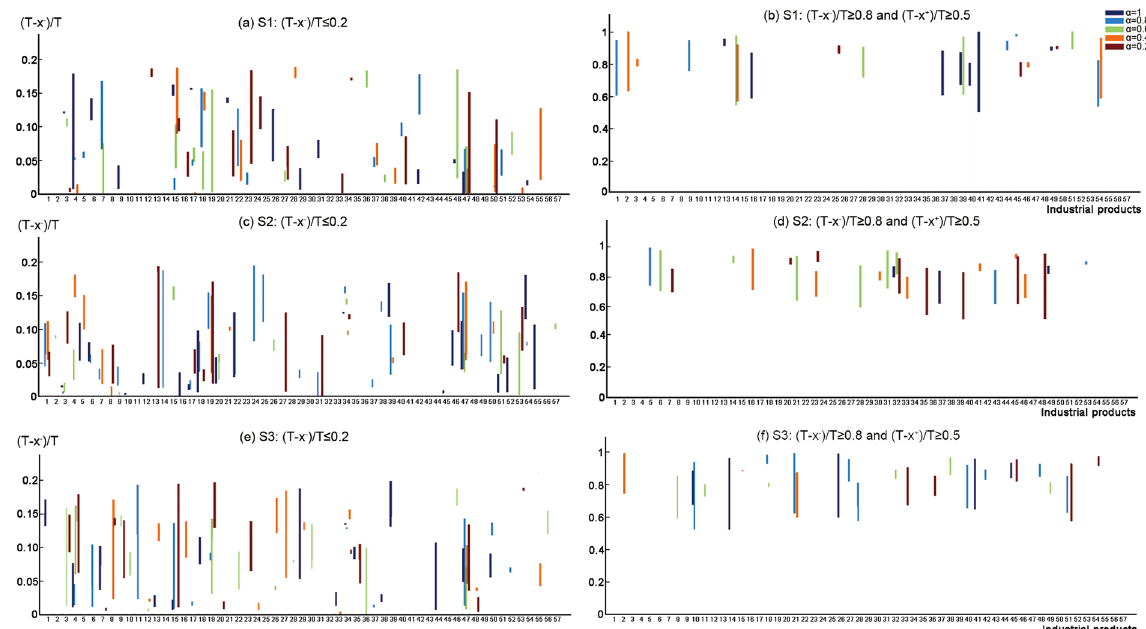
Figure 2. Output ratios of industrial products in